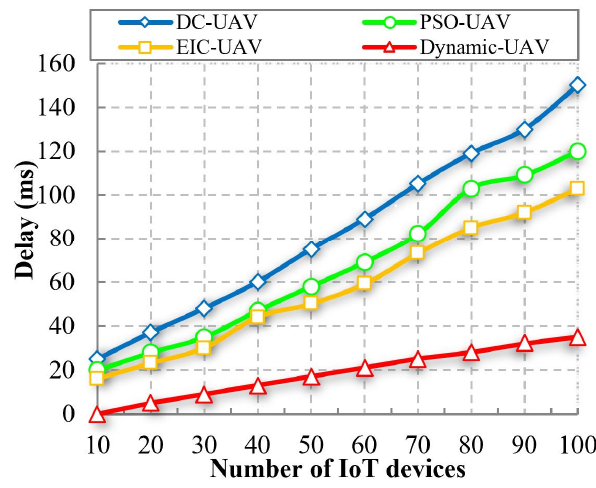
Figure 10. Delay vs. Number of IoT devices.